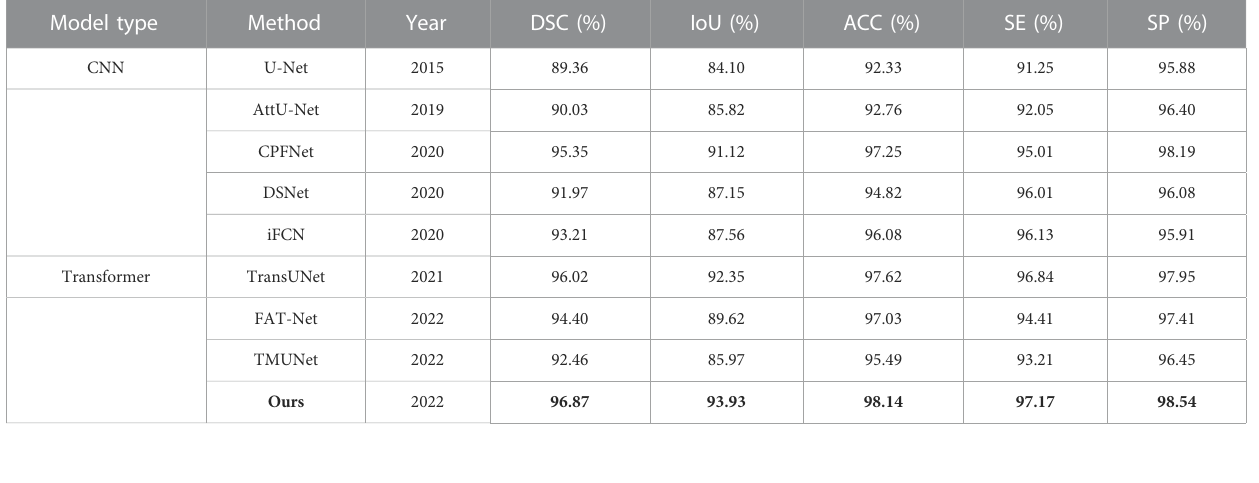
TABLE 7 Statistical comparison of the segmentation results on PH2. The best results are shown in bold.